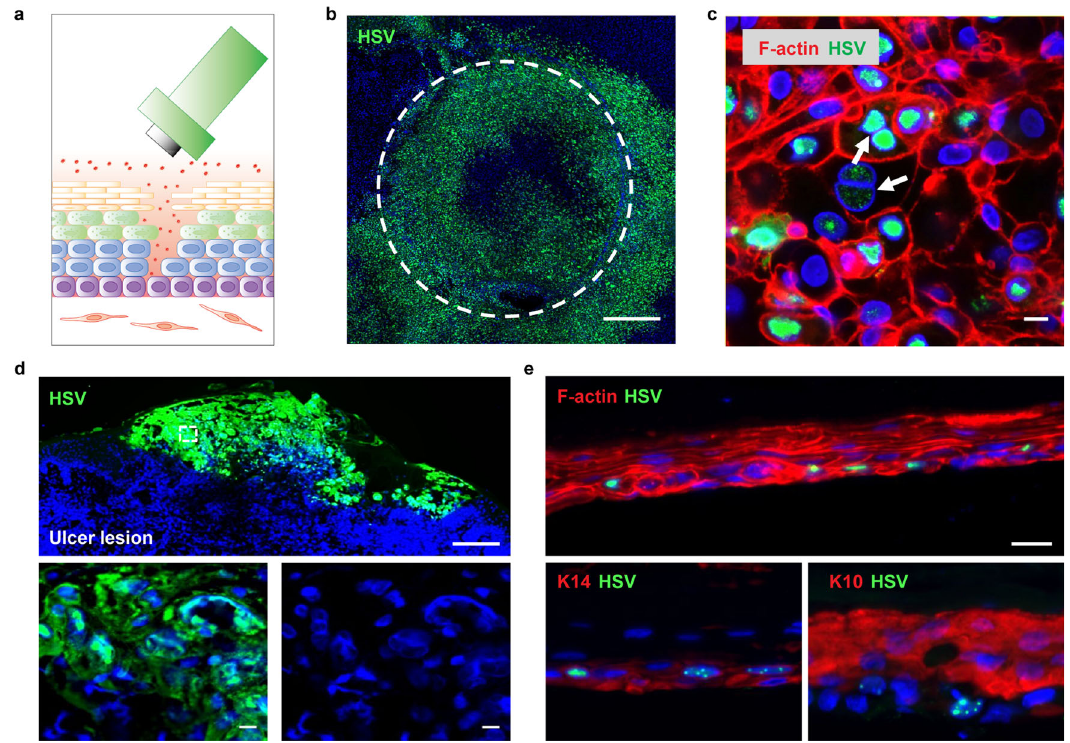
Fig. 3 | HSV Infection in epidermis of human skin-on-chip and native human skin. a Schematic of epidermal HSV infection protocol by a biopsy punch. HSV-1 K26 virus (10 6 PFU) was added on top of the epithelium after the strati fi ed epi- dermis was disrupted by a 1.5mm biopsy punch. b GFP expression of HSV-1 K26- infected 3-D skin-on-chip epidermis at 24h post infection. Image shown as a maximum intensity projection of confocal z stacks. HSV-1 K26 (green). Scale bar: 500 µ m. c HSV infection in the epidermis of skin-on-chip. Arrows indicate